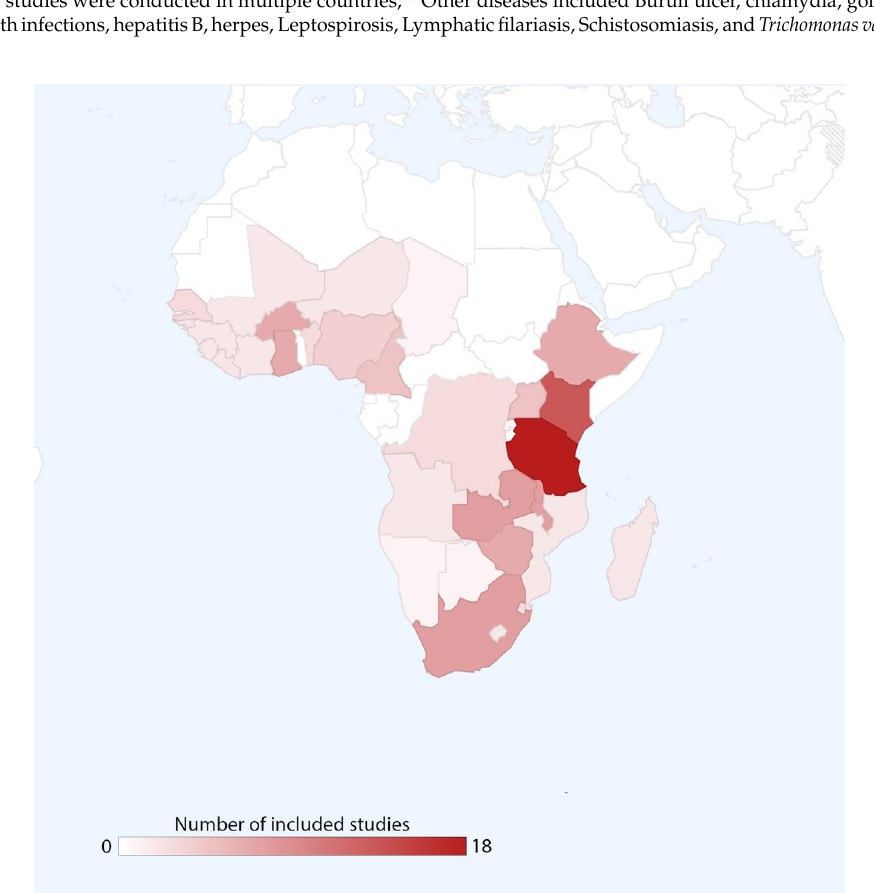
Table 1. Summary of number of studies and their locations per disease group.